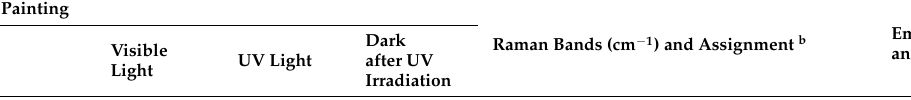
Table 2. Measurement areas of the four paintings examined at the Black Light Art exhibition. For each area, the color, the wavenumbers of the Raman bands, and the wavelengths of the emission and visible absorption maxima are reported. For each color, the appearance in visible light, UV light (Wood’s lamp), and, when appropriate, in the dark after UV irradiation is shown. The materials identified based on the spectroscopic data are also indicated a .